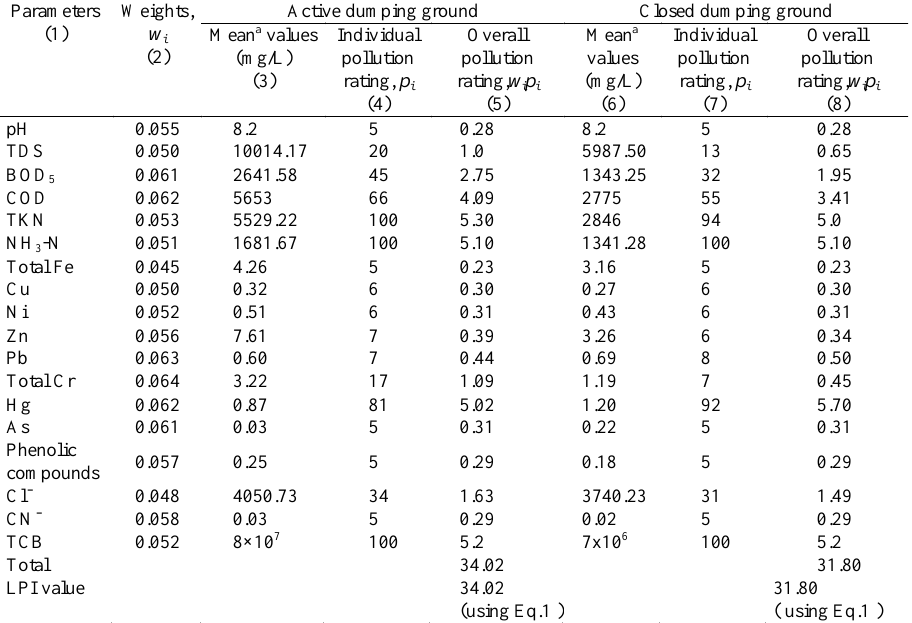
Table 2: Leachate pollution index (LPI) for the active and closed dumping ground at Dhapa, Kolkata Parameters